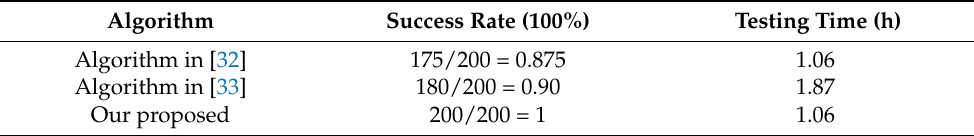
Table 8. Comparison of test results of each algorithm in simulation Figure 6a.